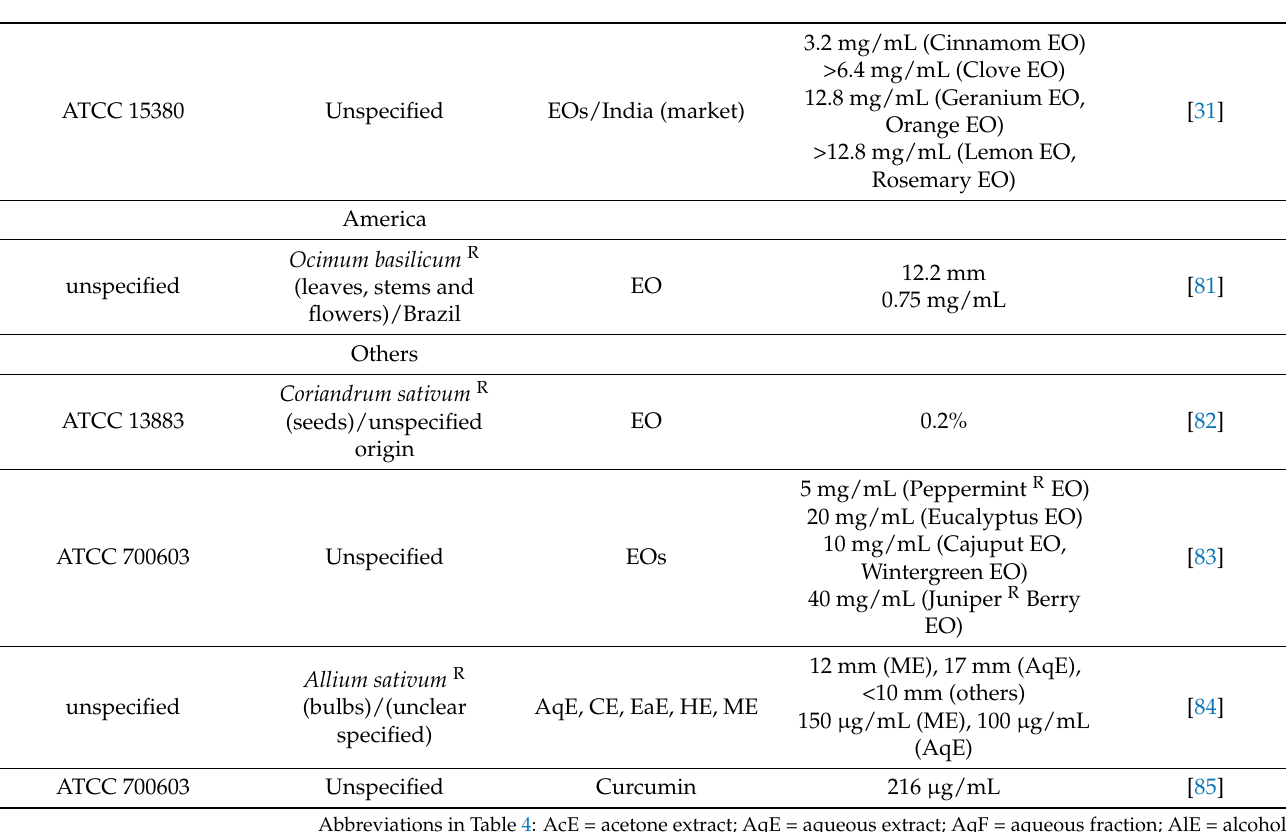
Abbreviations in Table 4: AcE = acetone extract; AqE = aqueous extract; AqF = aqueous fraction; AlE = alcoholic extract; BE = butanol extract; CE = chloroform extract; CF = chloroform fraction; DcmE= dichloromethane extract;